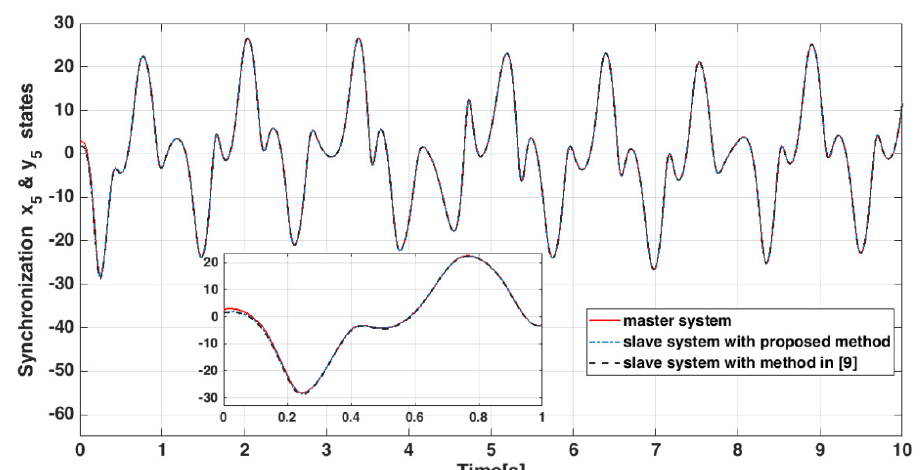
Figure 12. States 𝒙 𝟓 and 𝒚 𝟓 Figure 12. States x 5 and y 5 .